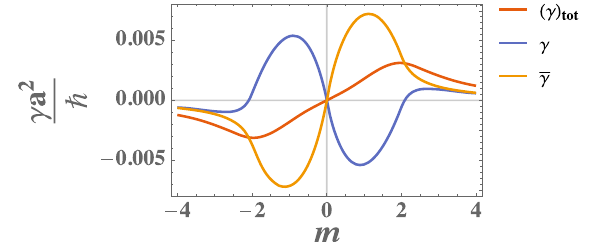
; γ , and ¯ γ as a function total